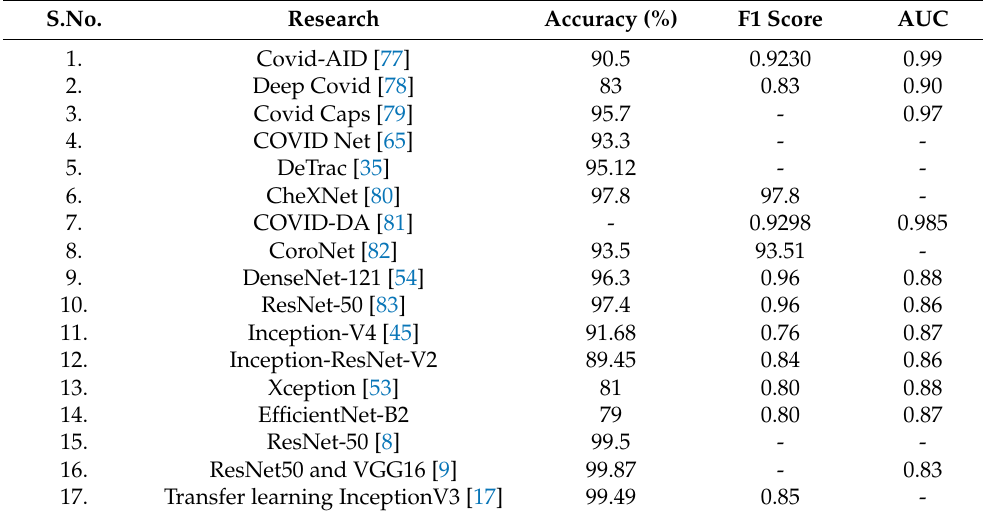
Table 3. Performance of reviewed detection